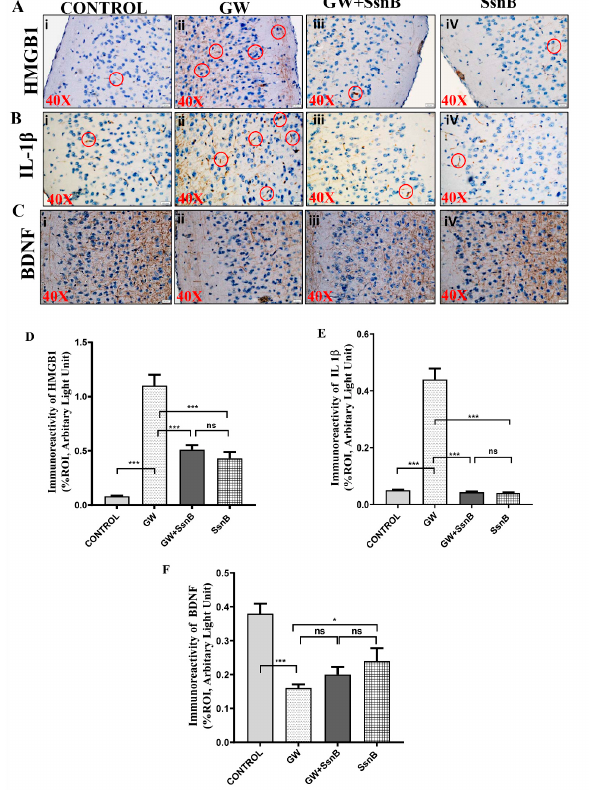
(red) / ASC2 (green) (Figure 5A) was performed using immunofluorescence microscopy. Colocalizations were observed in the cytoplasmic region of the cells as yellow dots and are marked in the representative images by white circles. Images were taken at 60 × magnification. Bar graphs depicting morphometric analysis of NLRP3 / ASC2 (Figure 5C) colocalizations are represented as mean ± SD of the %ROI (mean value calculated from three separate fields of a sections). Significance